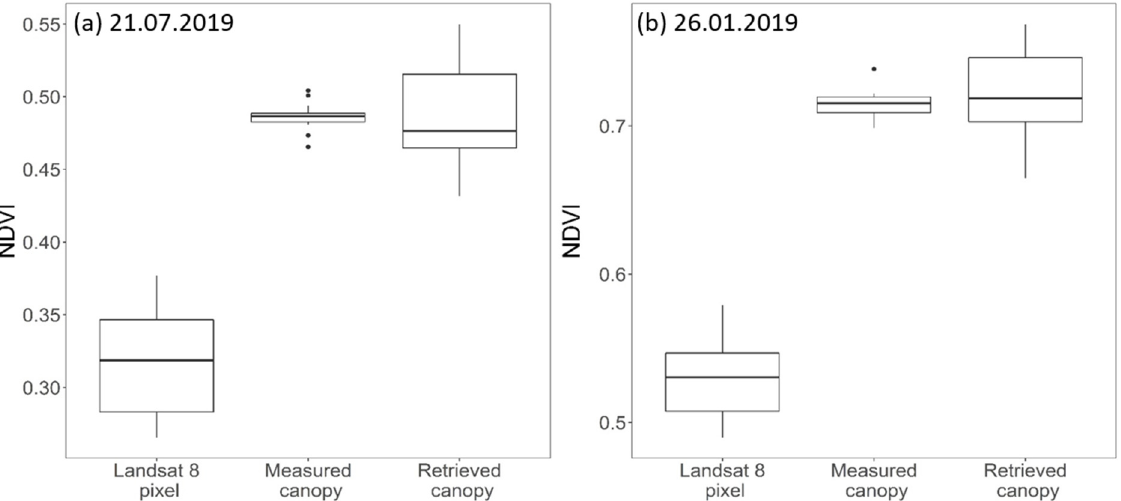
Figure 7. Boxplots of satellite Landsat 8 pixel NDVI (original and retrieved) and directly measured canopy NDVI over 19 pixels around the tower (see Figure 1) on a summer day (( a ) 12 July 2019) and a winter day (( b ) 26 January 2019). The measured canopy NDVI is based on the high-resolution (5 cm) UAV measurements, and the Landsat 8-retrieved canopy NDVI is based on our retrieval algorithm. The root mean square error between the measured and retrieved canopy NDVI was 0.03 in both seasons.